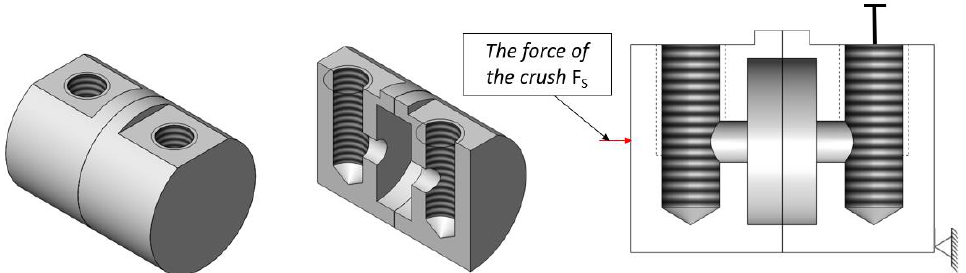
Figure 3. View of the assembled kit for the leak test.